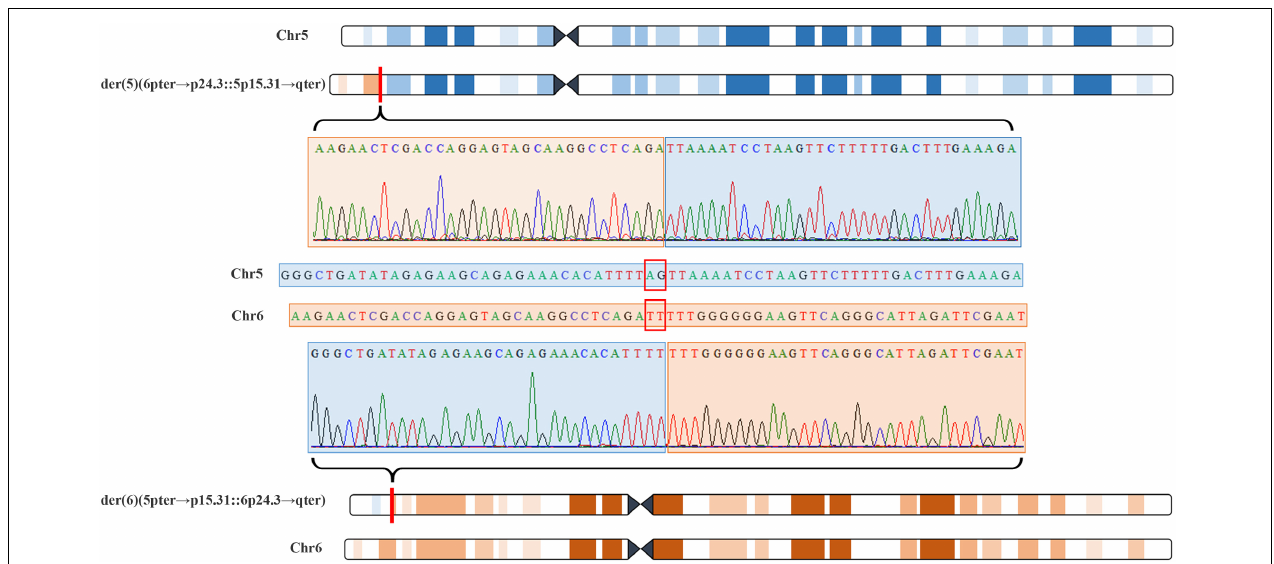
FIGURE 5 | Whole genome sequencing (WGS) and Sanger sequencing identified balanced translocation of pregnant woman’s father (III-2). Structure sketch map of chromosome 5 (blue) and chromosome 6 (yellow) are shown at the top and bottom. The Sanger sequencing results across the breakpoints on chromosome 5 and chromosome 6 are displayed, respectively, in the middle. Red box indicates 2-bp deletion in the breakpoint junction on chromosome 5 and chromosome